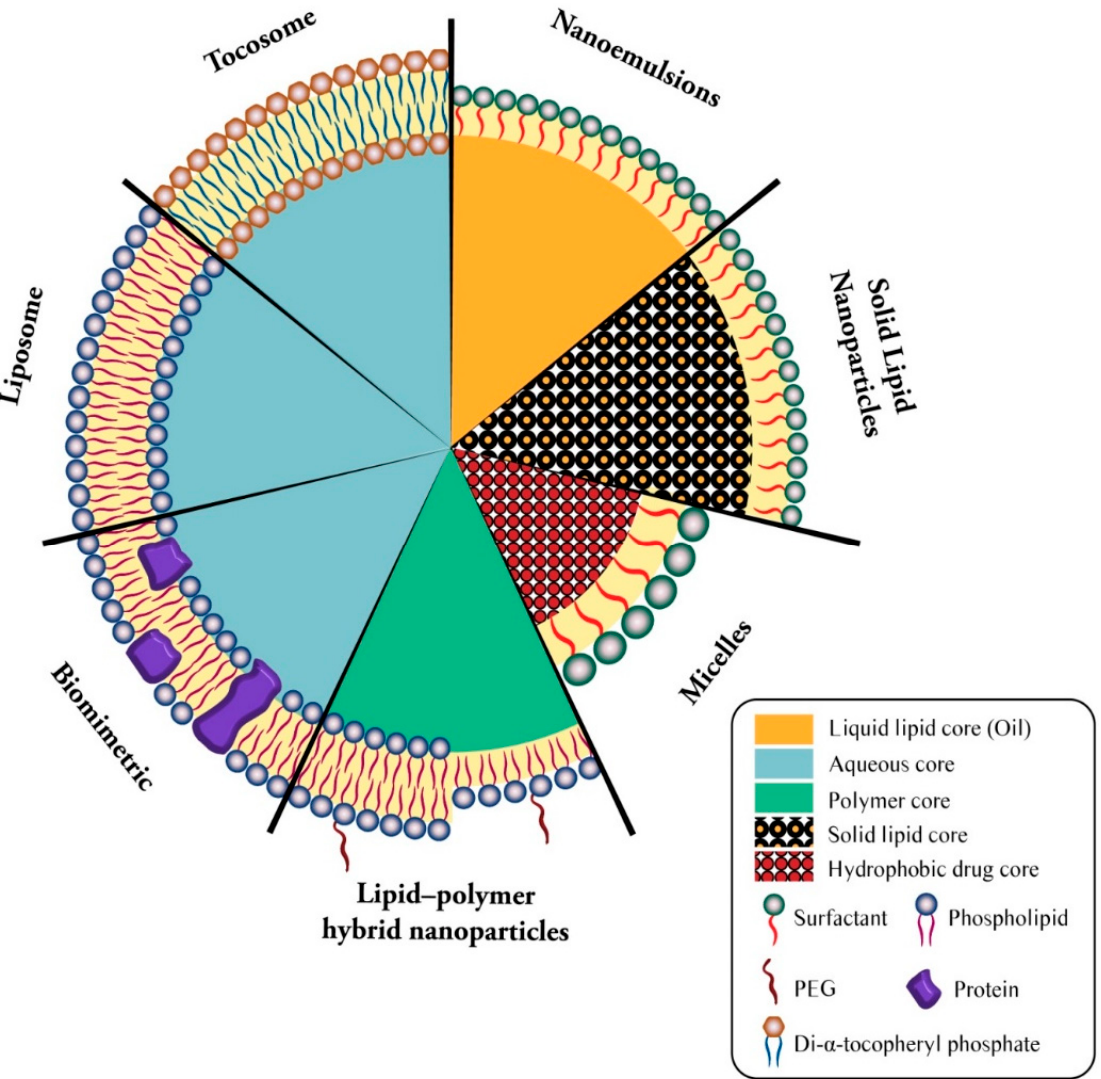
Figure 2. Simplified structure of main lipidic carrier systems. Seven types of lipidic vaccine/drug carriers consists of liposome (phospholipid bilayer + aqueous core), biomimetric (proteinated phospholipid bilayer + aqueous core), lipid-polymer hybrid nanoparticles (bi- or monolayer phospholipid + polymer core), micelles (surfactant monolayer + hydrophobic drug core), solid lipid nanoparticles (surfactant monolayer + solid lipid core), nanoemulsion (surfactant monolayer + liquid lipid core), and tocosome (Di- α -tocopheryl phosphate bilayer + aqueous